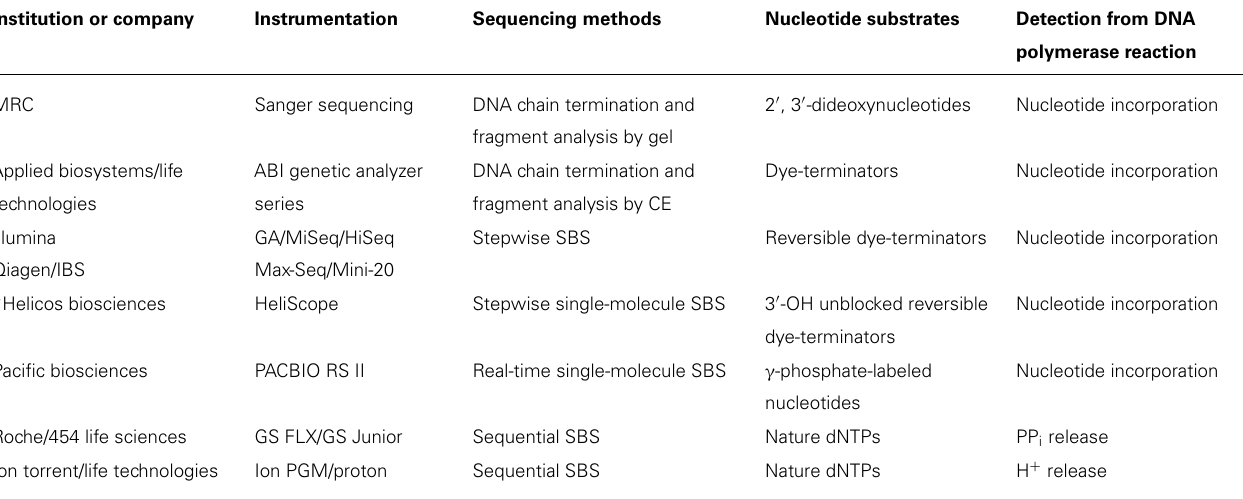
Table 2 | Generations of DNA polymerase-based DNA sequencing